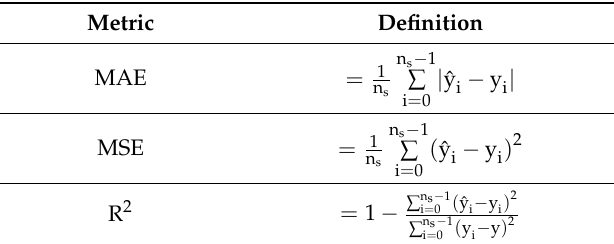
Table 2. Evaluation metrics (n s : number of samples).